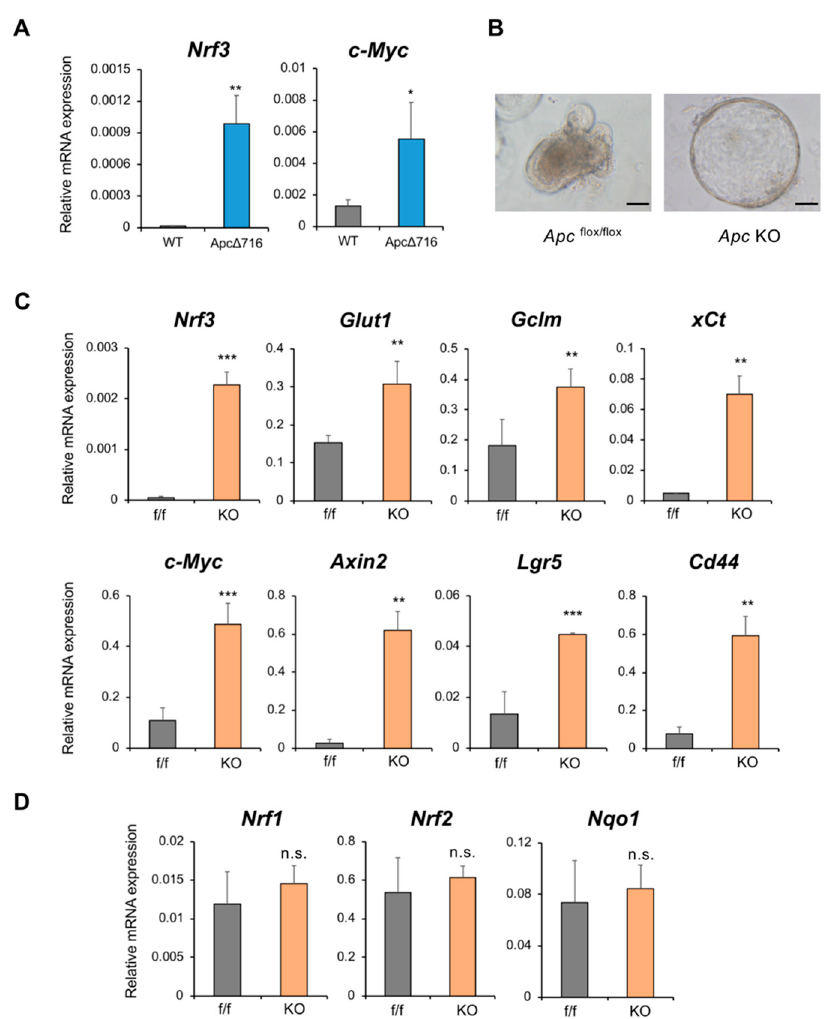
Figure 5. Apc gene deletion induces Nrf3 gene expression in mouse intestine and organoids. ( A ) Nrf3 expression, along with that of the β -catenin target gene c-Myc , was remarkably higher in intestinal tumors from Apc ∆ 716 mice than in those from wild-type mice ( n = 4). ( B ) Appearance of intestinal epithelial organoids derived from Apc flox / flox and Apc KO mice. Scale bar, 20 µ m. ( C ) Loss of the Apc gene in organoids augmented the expression of the Nrf3 and Glut1 genes, along with that of β -catenin target genes ( c-Myc , Axin2 , Lgr5 ), as shown by qRT-PCR analysis. f / f and KO stand for Apc flox / flox and Apc KO, respectively. The Lgr5 and Cd44 genes are stem / progenitor cell markers of intestinal epithelial cells. Gclm and xCt are ARE-containing target genes of CNC family proteins. ( D ) Gene expression of the Nrf3 -related factors Nrf1 and Nrf2 was not altered . Nqo1 is a target gene of Nrf2. The mRNA expression of each gene was normalized to Gapdh expression, and the data are presented as the mean ± SD ( n = 3). * p < 0.05, ** p < 0.01, *** p < 0.005, n.s., not significant ( t -test).